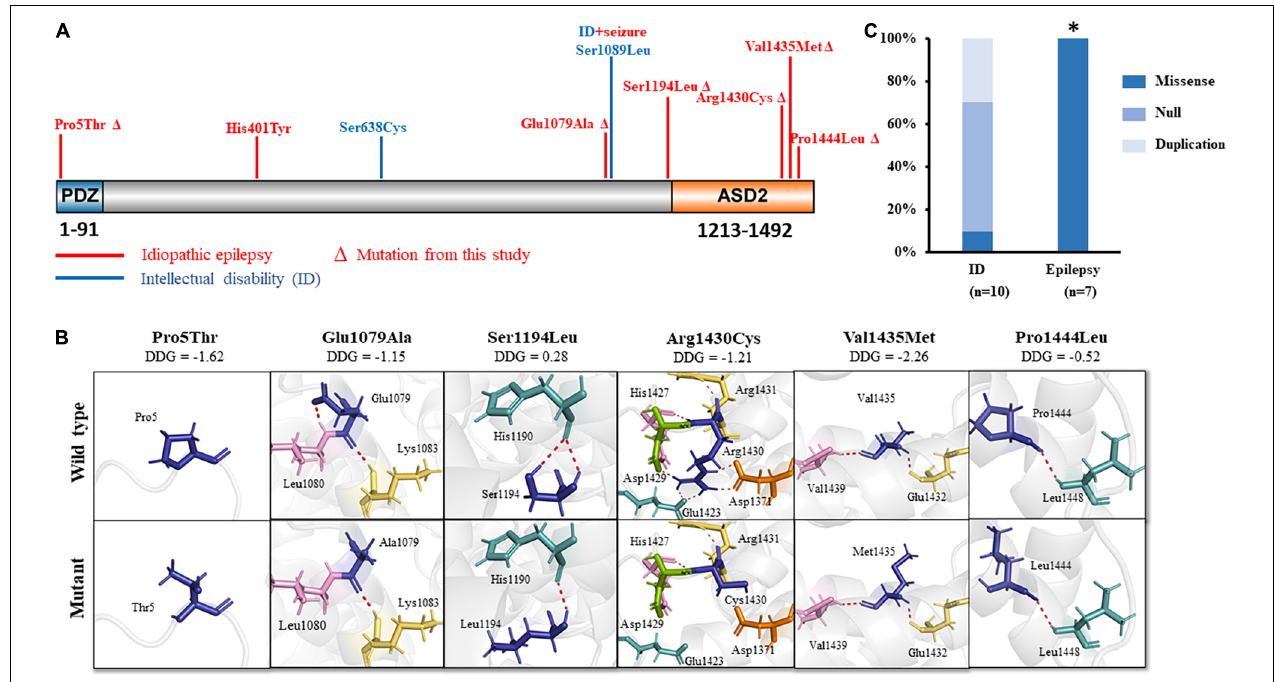
FIGURE 3 | Schematic illustration of SHROOM4 variants. (A) Linear schematic of missense SHROOM4 mutations and their locations on SHROOM4 protein. Mutations associated with epilepsy were shown in red color. Mutations associated with ID were shown in blue. (cid:49) The mutation was found in this study (B) Changes of hydrogen bonds and free energy change value (DDG) of the mutations. (C) The proportion of missense mutations in epilepsy and ID. *The proportion of missense mutations in epilepsy is significantly higher than that in